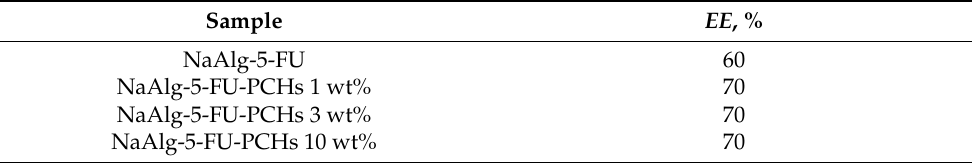
Table 3. 5-FU encapsulation efficiency ( EE , %) of neat NaAlg beads and hybrid beads.